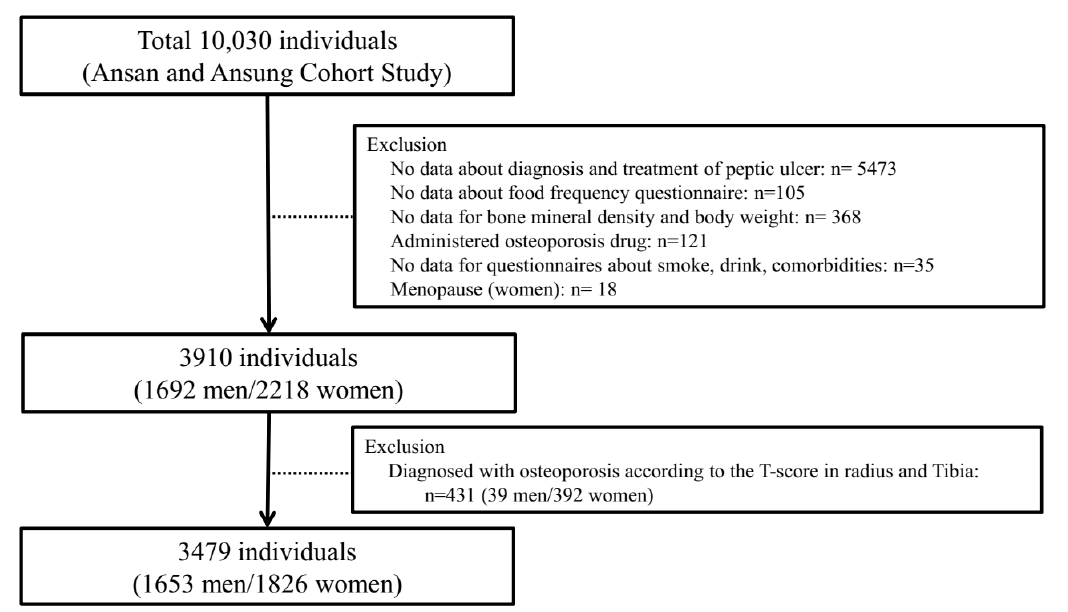
Figure 1. Study population in the present study obtained from the Ansung–Ansan cohort